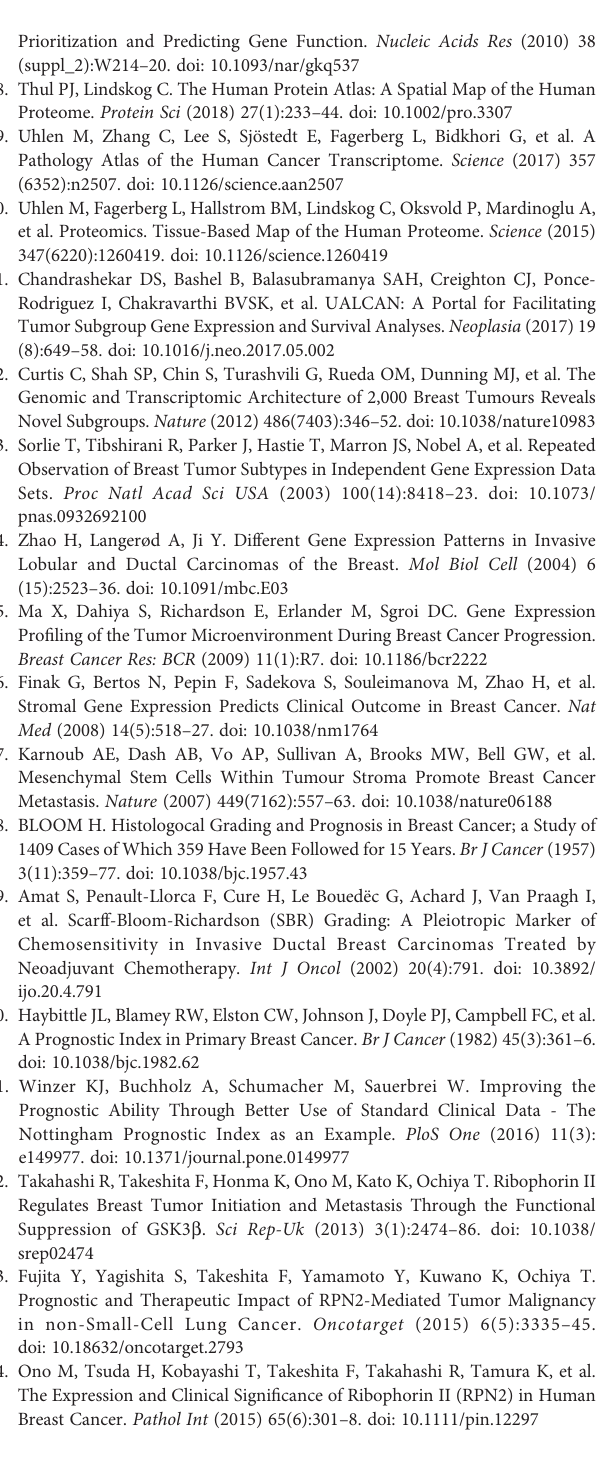
computed for each pairwise comparison. P<0.05 was considered statistically signi fi cant. SBR, Scarff Bloom & Richardson grade. Supplementary FigureS5 | Therelationships between the OST subunits and the NPI criteria (data from bc-GenExMiner v4.5). (A – L) Box plots of individual OST subunit ’ s expression according to NPI. Global signi fi cant differences between groups were assessed by Welch ’ s test, and Dunnett – Tukey – Kramer ’ s test